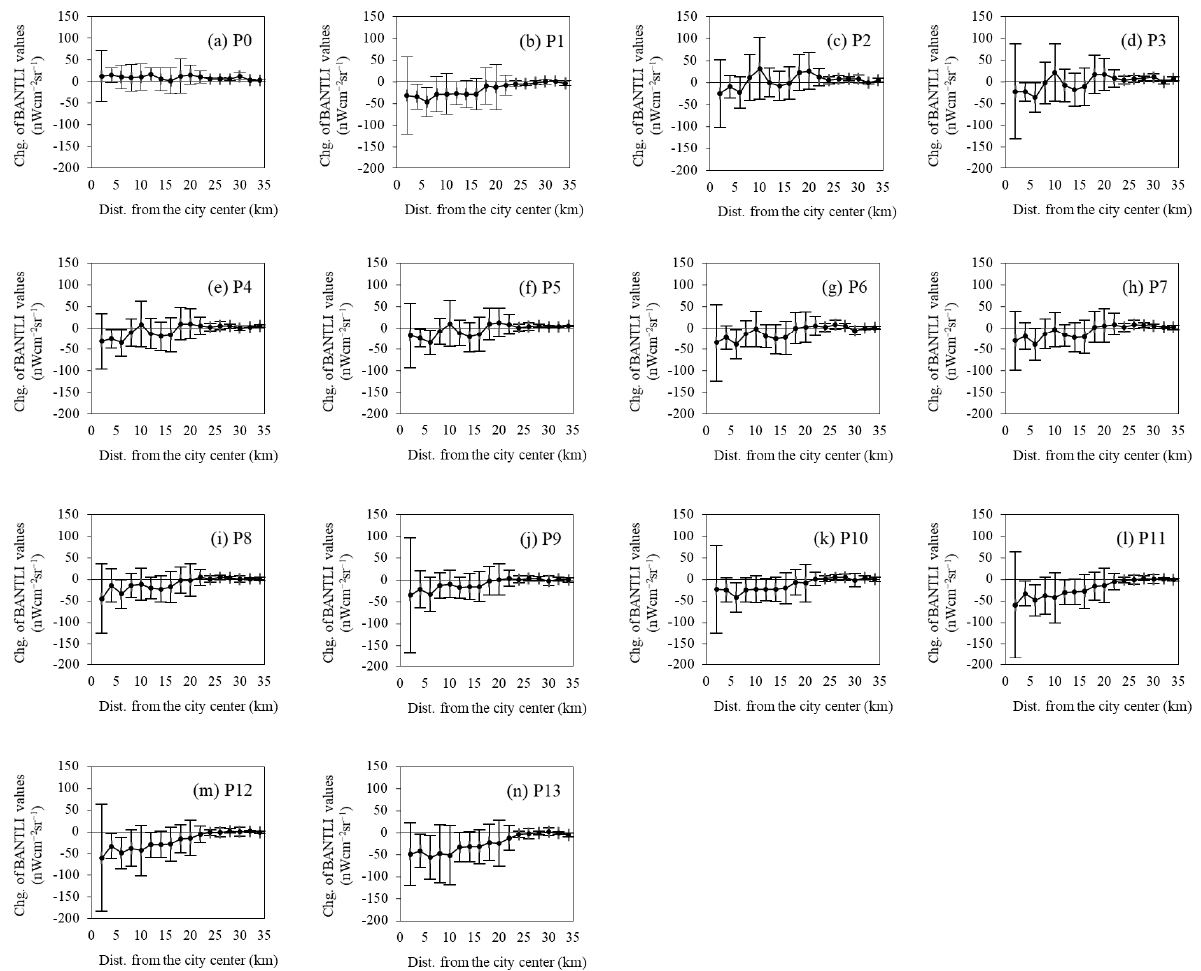
Figure 13. The mean (black line) and STD (error bar) of BANTLI brightness differences for the periods in concentric rings from Makkah center.